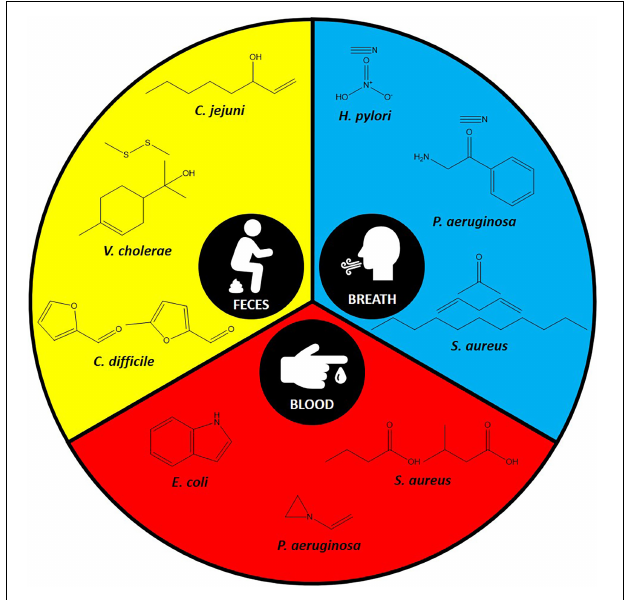
FIGURE 2 | Some of the specific volatiles identified in the most commonly used specimens for each